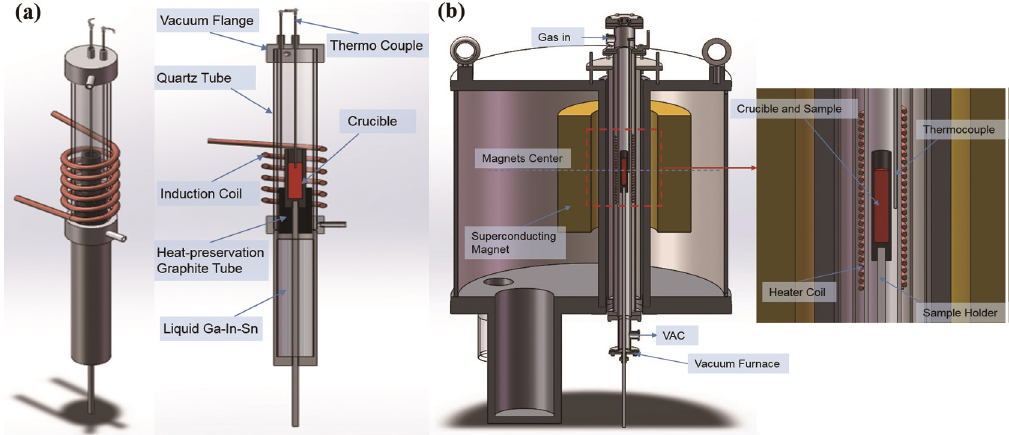
Figure 1. Schematic diagram of the experimental apparatus: ( a ) Directional solidification; ( b ) Heat treatment in a high magnetic field.